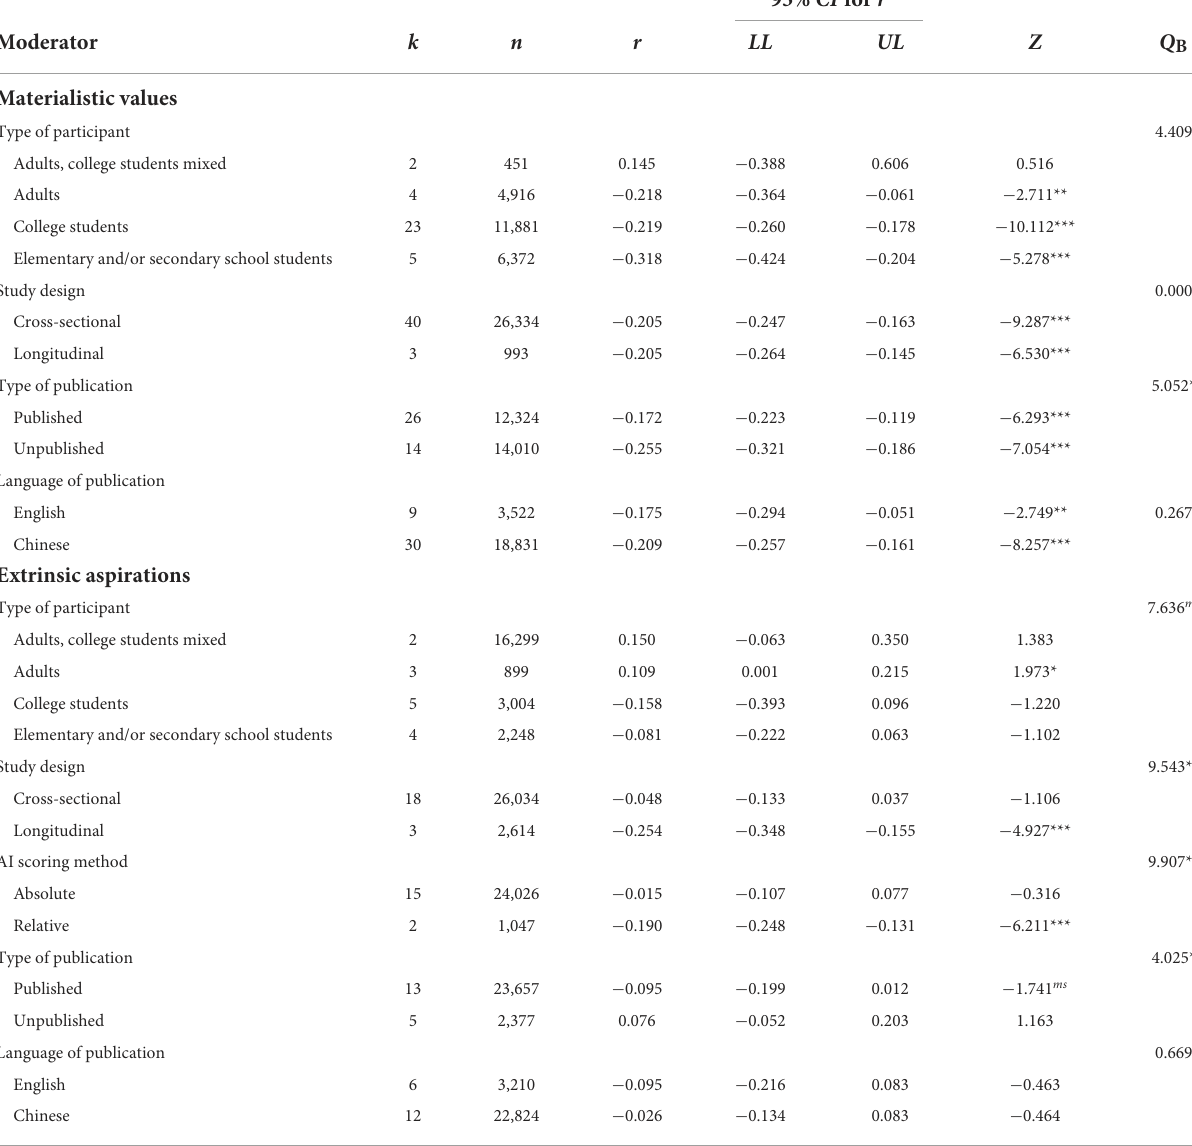
TABLE 5 Type of participant, study design, type of publication, language of publication, and AI scoring method as